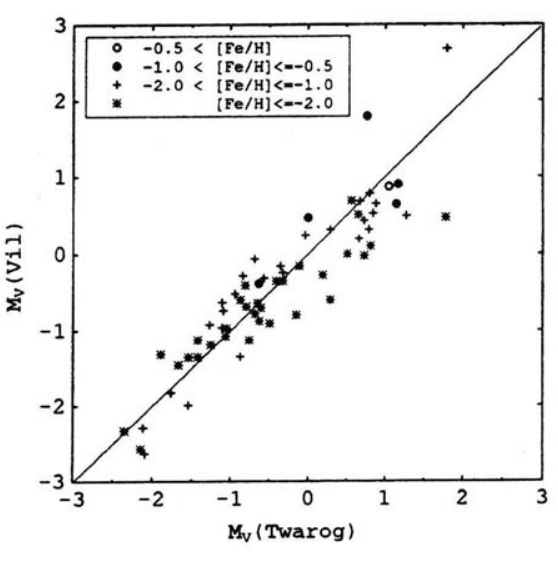
Fig. 6. Comparison of our absolute magnitudes with those from Anthony-Twarog & Twarog (1994). The solid line is a 45°